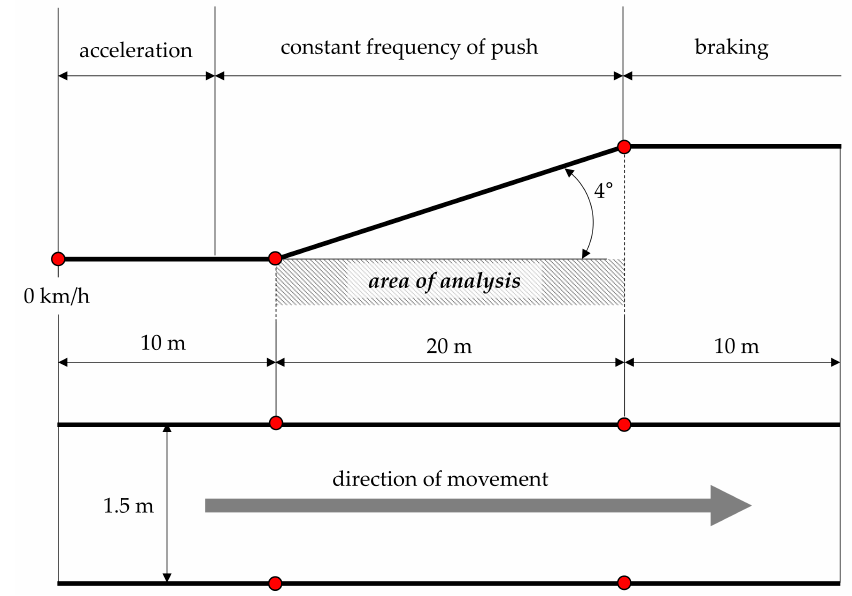
Figure 1. Dimensions of the track used in the